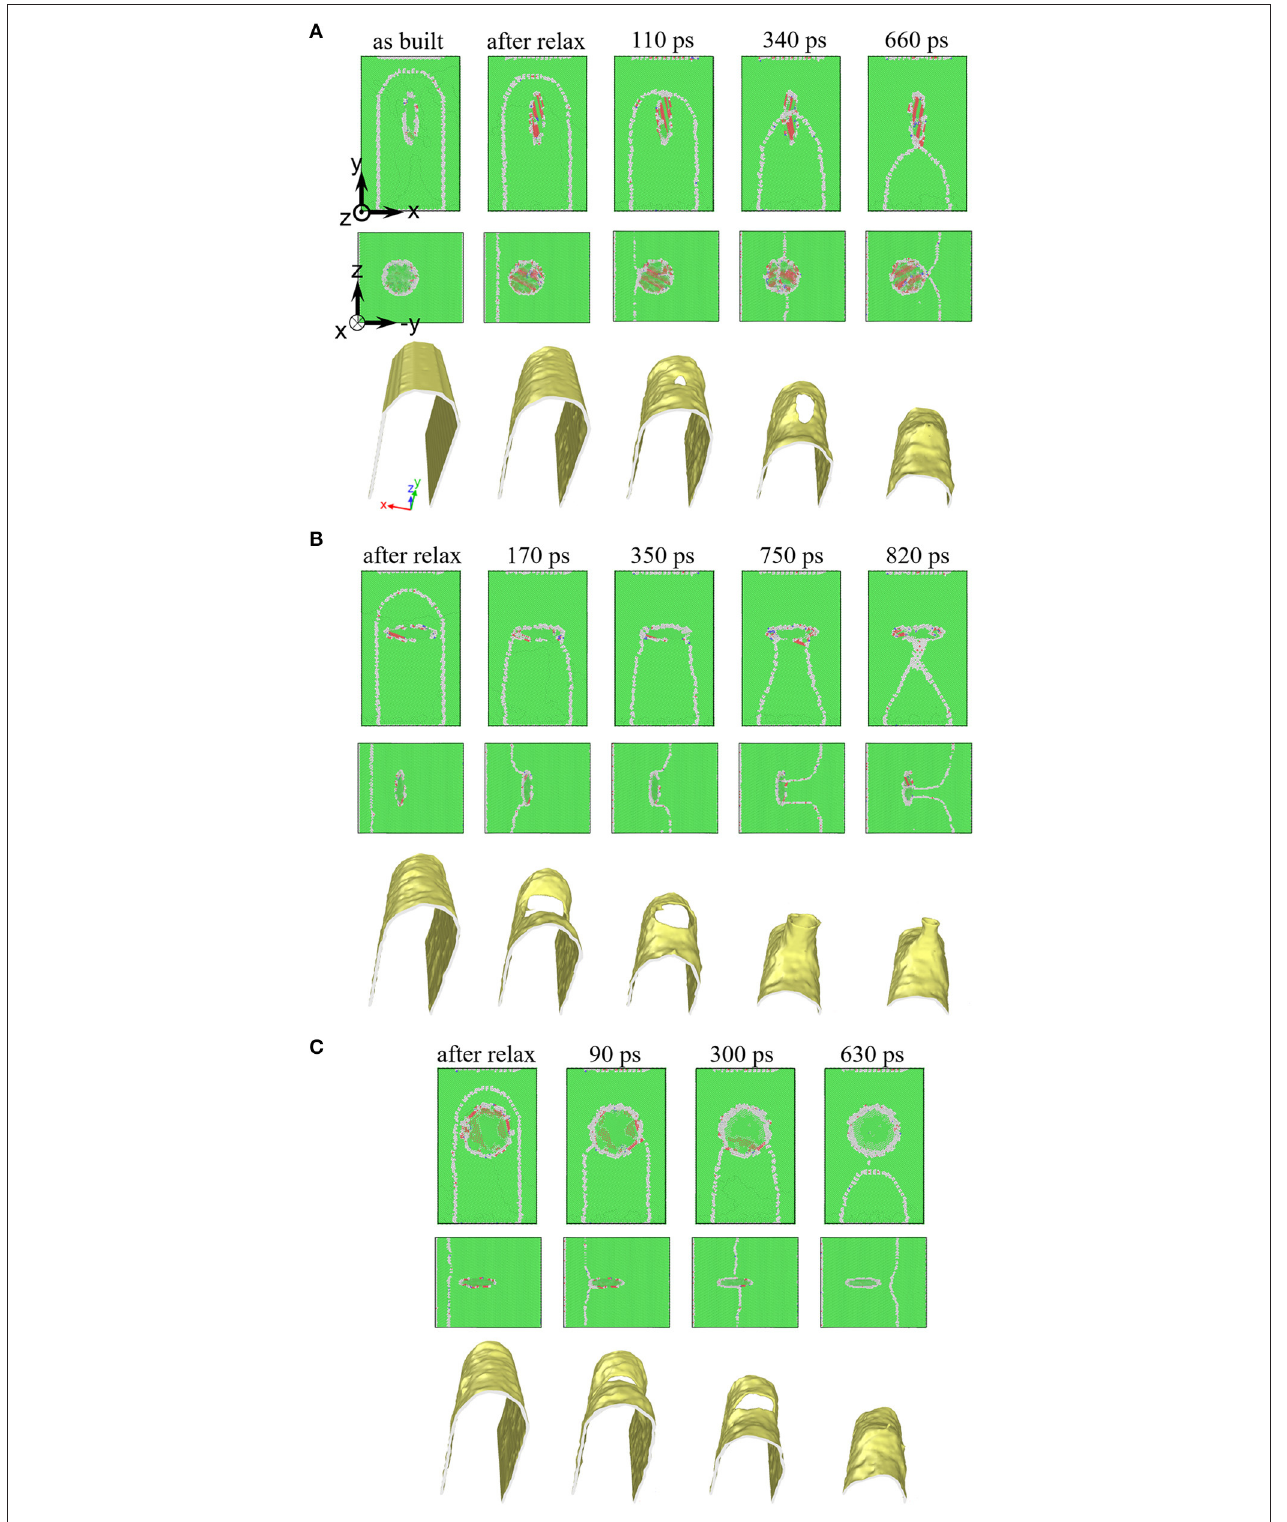
FIGURE 2 | Snapshots and boundary configurations during the GB–particle interaction. (A) Full cutting of the ellipsoidal particle with b // X and aspect ratio (AR) = 0.25; (B) partial cutting of the particle with b // Y and AR = 0.25; (C) no cutting of the particle with b // Z and AR = 0.25. The colors of the atoms are assigned based on their local environments: green, gray, and red for fcc, disorder, and hcp, respectively (for interpretation of the references to color in this figure legend, the reader is referred to the web version of this article).